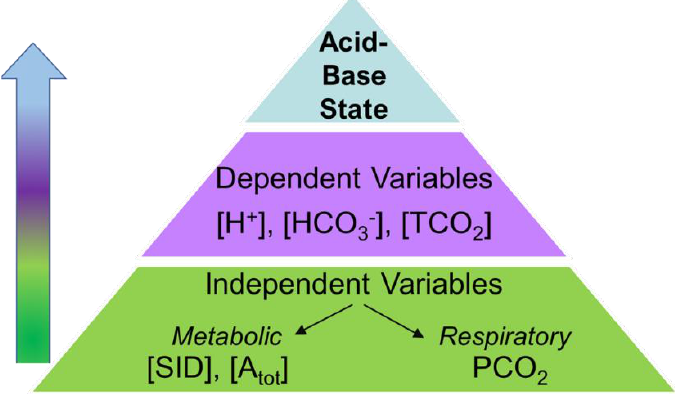
Figure 1. Schematic of the physicochemical approach to acid-base status. The independent variables [SID] (strong ion difference), the PCO 2 (partial pressure of carbon dioxide) and [Atot] (the total weak acid concentration) determine the concentrations of the dependent acid-base variables ([H + ], [HCO 3 − ], and total carbon dioxide concentration ([TCO 2 ]). [SID]= [Na + ] + [K + ] − [Cl − ] − [lactate −